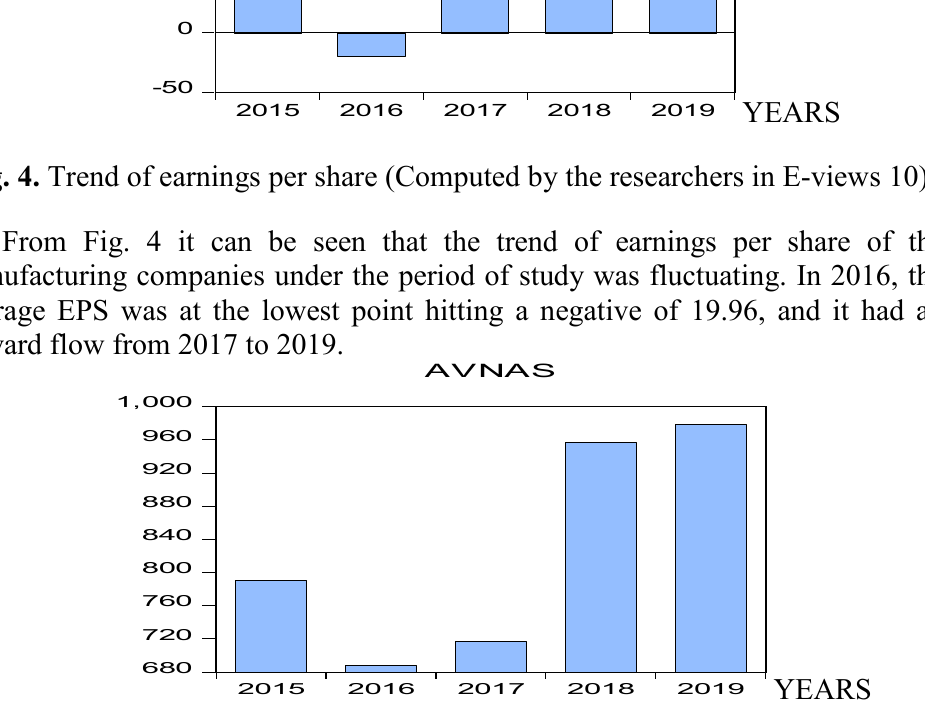
Fig. 5. Trend of net asset per share (Computed by the researchers in E-views